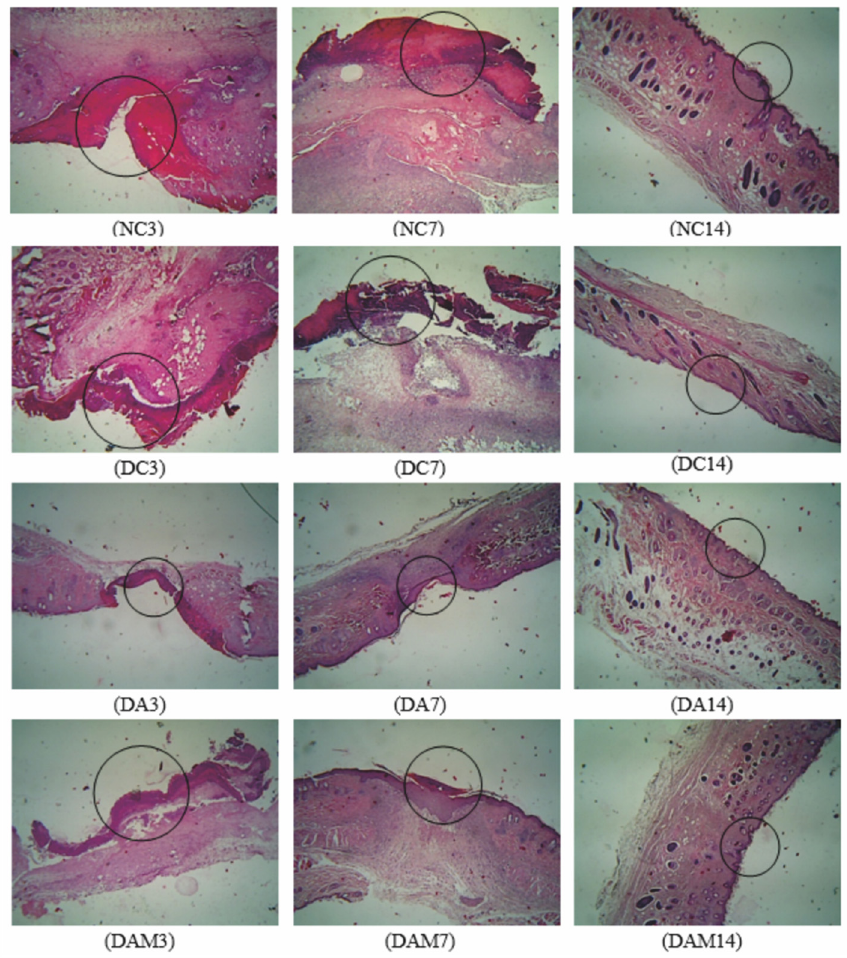
Figure 3. Histopathology analysis of wound width was measured on the three variation times. A circle in the picture indicates the wound width in the specimen. NC: normal group; DA: alginate treatment group; DAM: alginate–mangosteen rind extract treatment group; and DC: diabetic group.